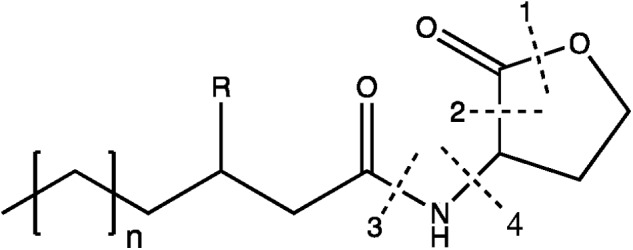
AHLs structure and its corresponding enzymatic degradations by QQ. The broken lines show the cleavages sites of four enzymes: (1) lactonase; (2) decarboxylase; (3) acylase; (4) deaminase. Adapted from Czajkowski and Jafra (2009).